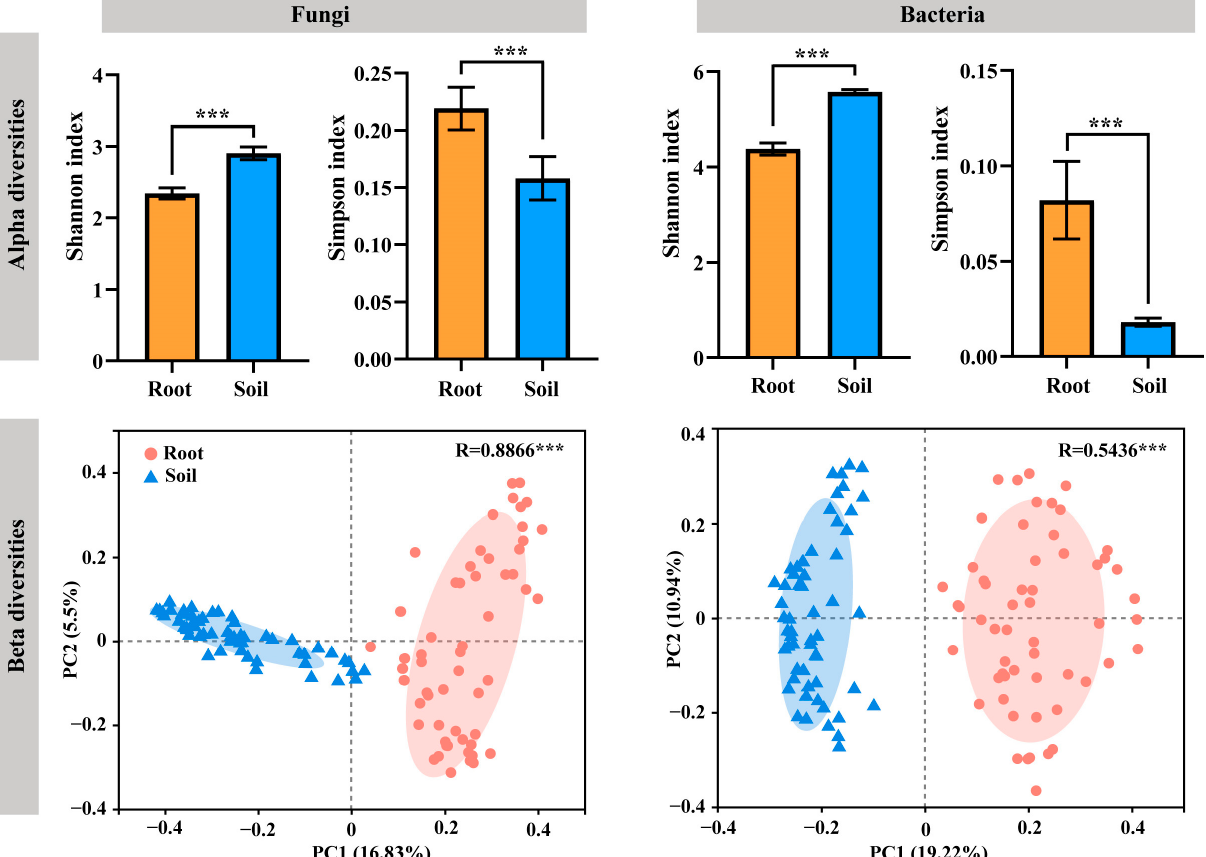
Figure 7. Alpha and beta diversities of microbial communities in rhizosphere soil and roots. Mann– Whitney U tests were used to evaluate differences between rhizosphere soil and roots. The error bar represents one standard error. Significant difference: *** p ≤ 0.001.